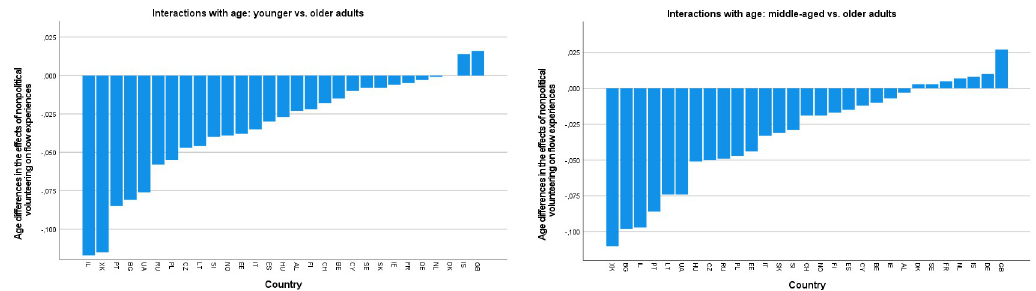
Fig 5. a. Country distribution of the interactions between nonpolitical volunteering and age (younger vs. older adults) in relation to flow experiences. b. Country distribution of the interactions between nonpolitical volunteering and age (middle-aged vs. older adults) in relation to flow experiences.